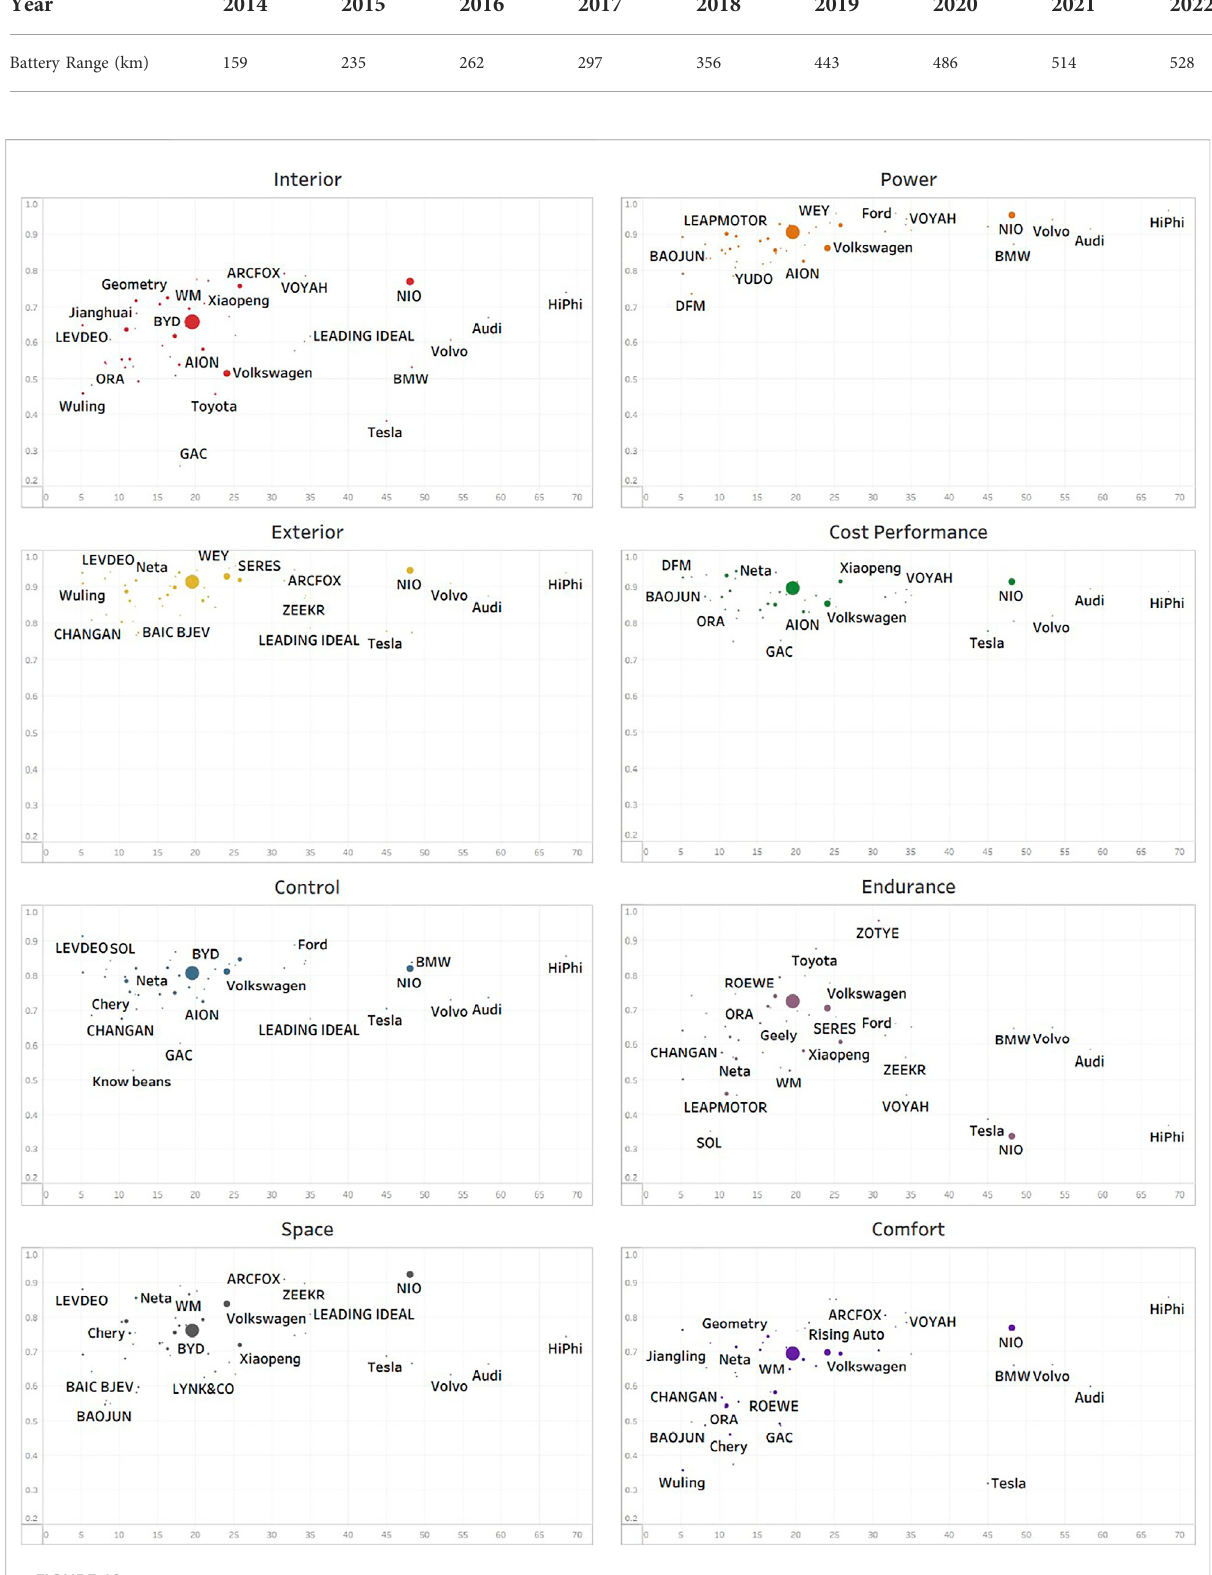
FIGURE 12 The eight-dimensional emotional distribution map of different brands of